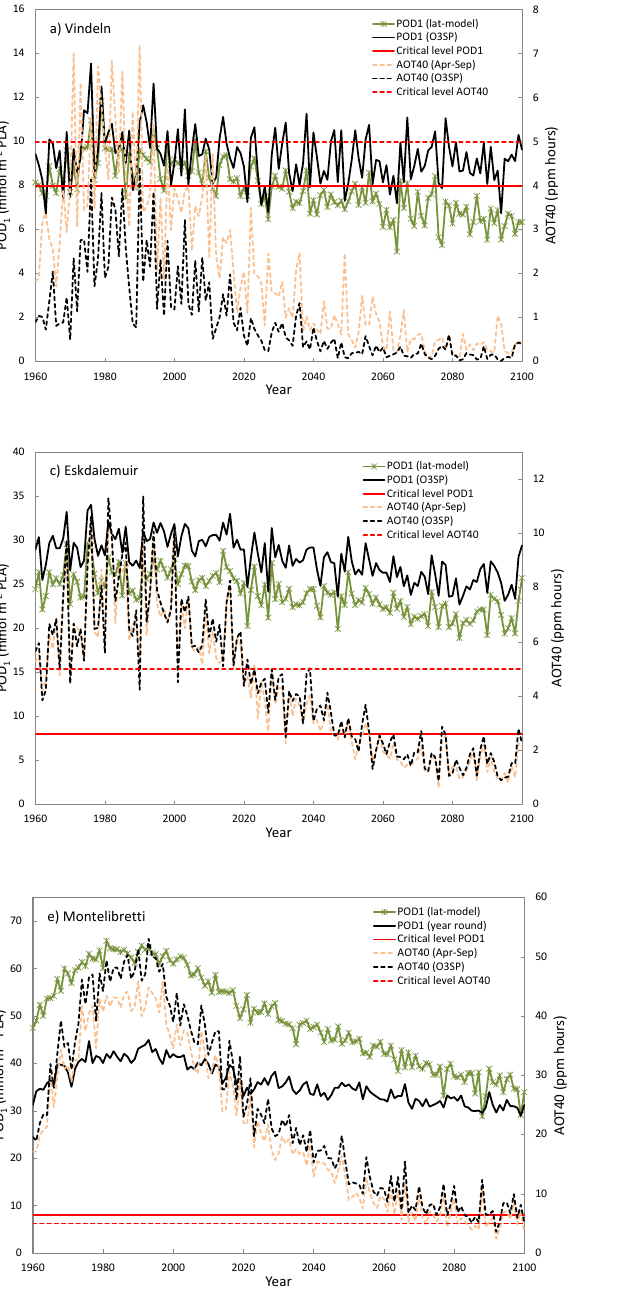
Figure 6. Modelled POD 1 and AOT40 at (a) Vindeln, (b) Vavihill, (c) Eskdalemuir, (d) Illmitz and (e) Montelibretti during 1960–2100. POD 1 was calculated based on the northern European Norway spruce parametrisation (Vindeln and Vavihill), the Atlantic Central European Scots pine parametrisation (Eskdalemuir), the Continental Central European Norway spruce parametrisation (Illmitz) and the Mediterranean Europe Holm oak parametrisation (Montelibretti). At all sites POD 1 and AOT40 was calculated for a fixed time period (not changing in time), for POD 1 based on the Mapping Manual latitude and altitude model (lat-model) and for AOT40 April–September. AOT40 and POD 1 were also calculated over the O 3 sensitive period (O 3 SP) shown in Fig. 4. At Illmitz and Montelibretti the O 3 SP was defined differently for POD 1 compared to AOT40 in order to follow the CLRTAP Mapping Manual as close as possible (see also Table S1 in the Supplement). For Illmitz the accumulation period of POD 1 was assumed to occur when the air temperatures fell within the T min and T max thresholds of the f temp relationship (POD 1 f temp ) and for Montelibretti the POD 1 accumulation period was year round with a fixed period of reduction in stomatal conductance during summer when soil water deficits are commonly high (POD 1 year